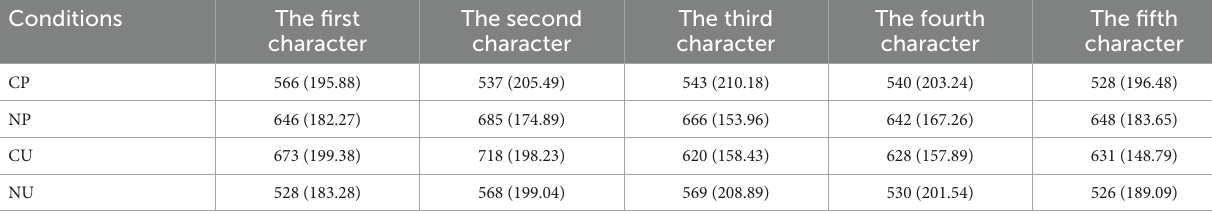
TABLE 3 The average reaction time (in milliseconds) and standard error of Chinese L2 learners.